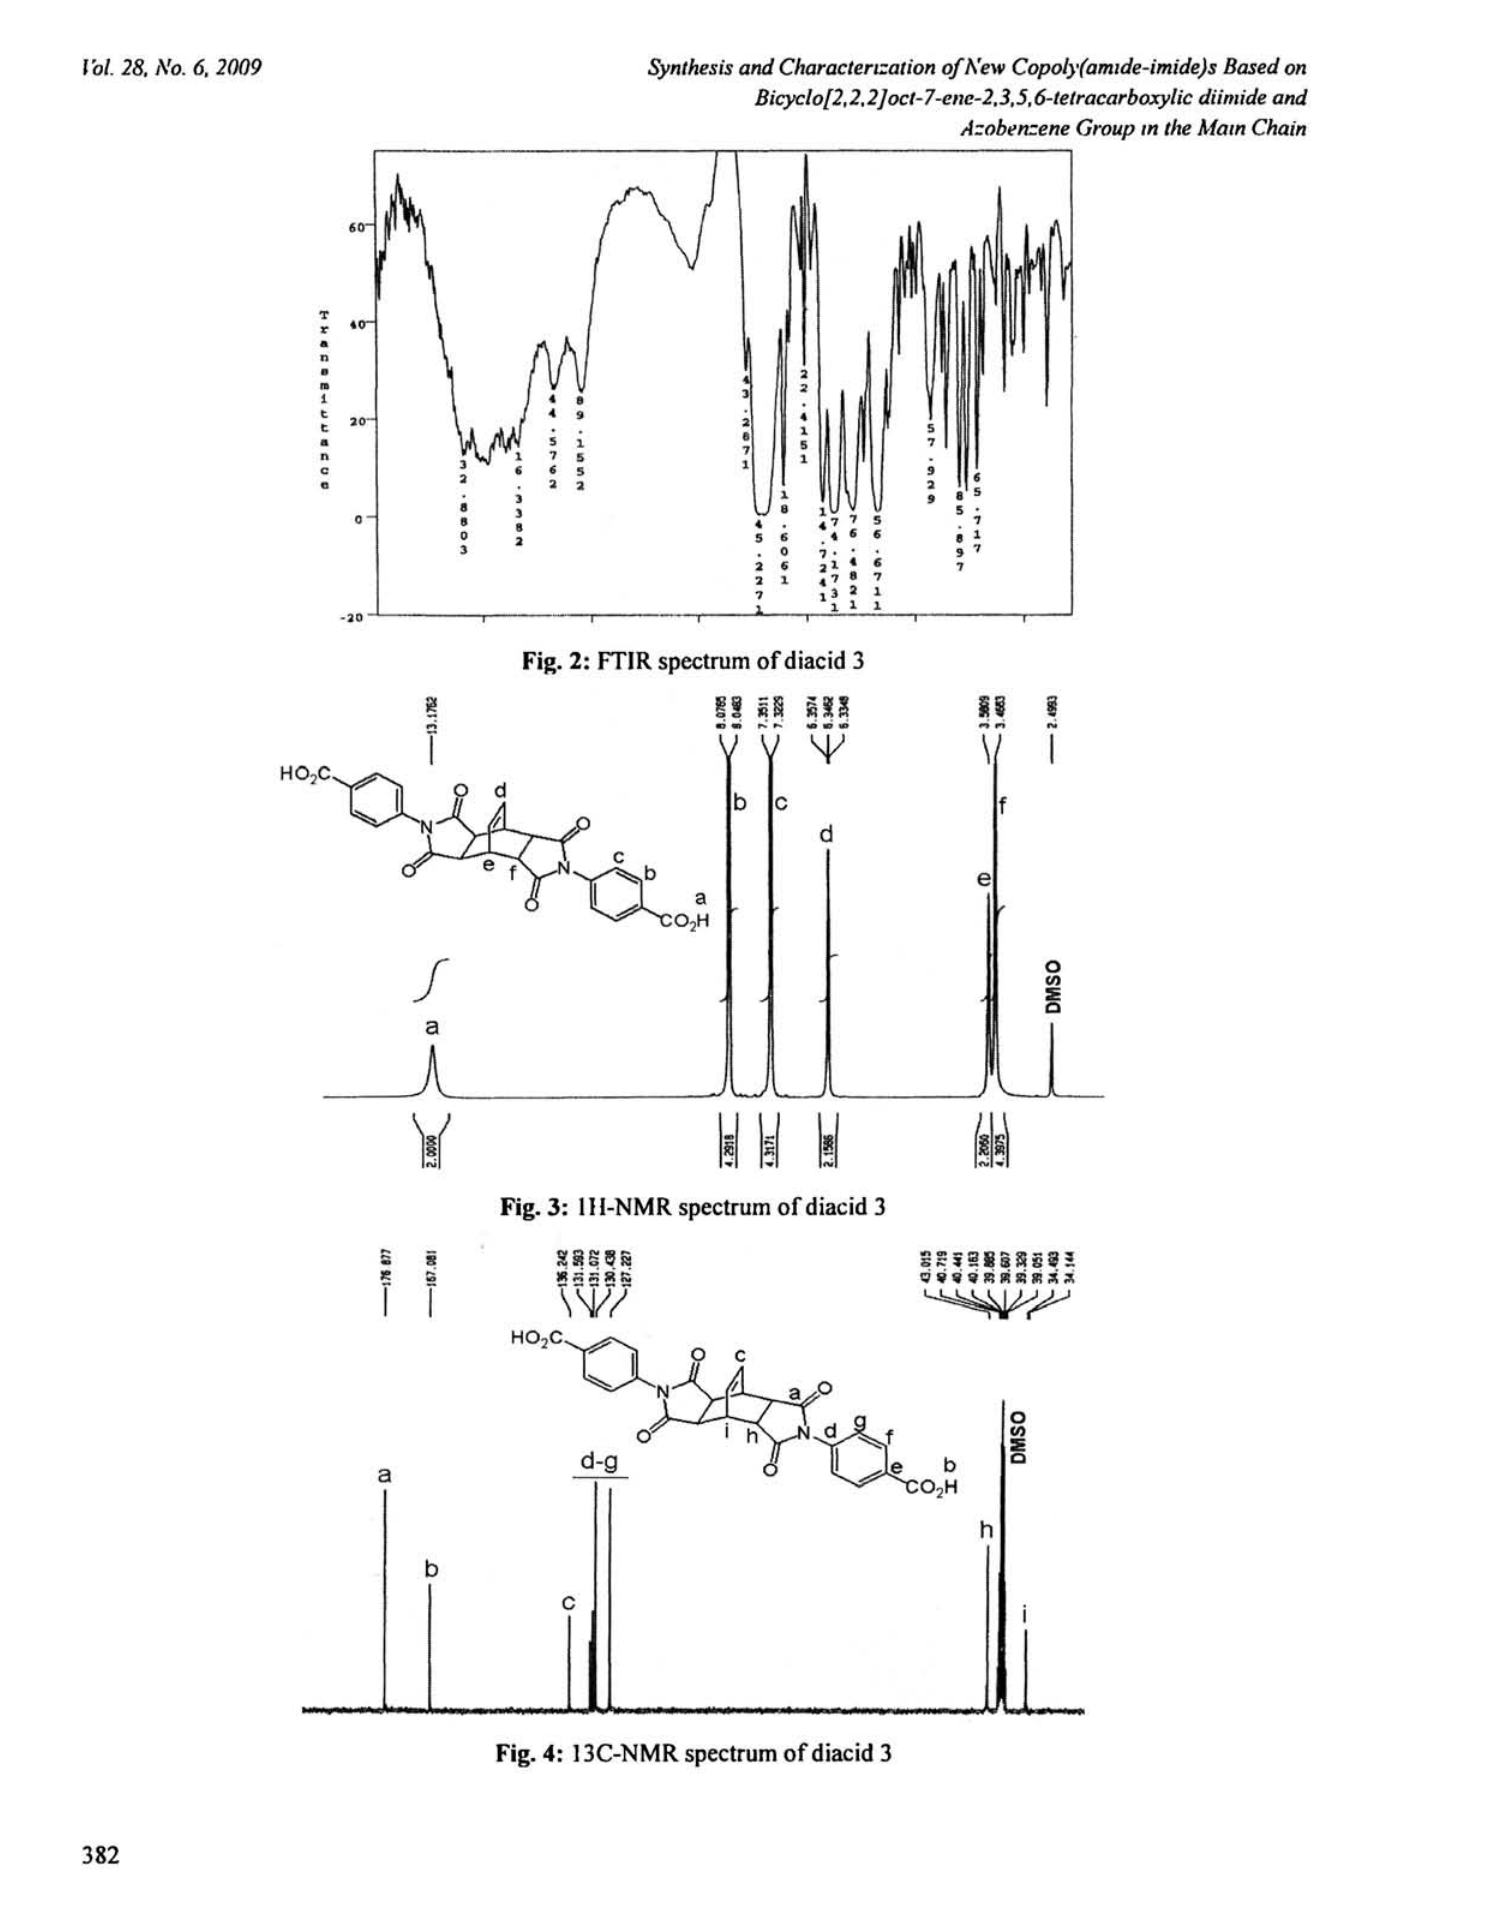
Fig. 4: 13C-NMR spectrum of diacid